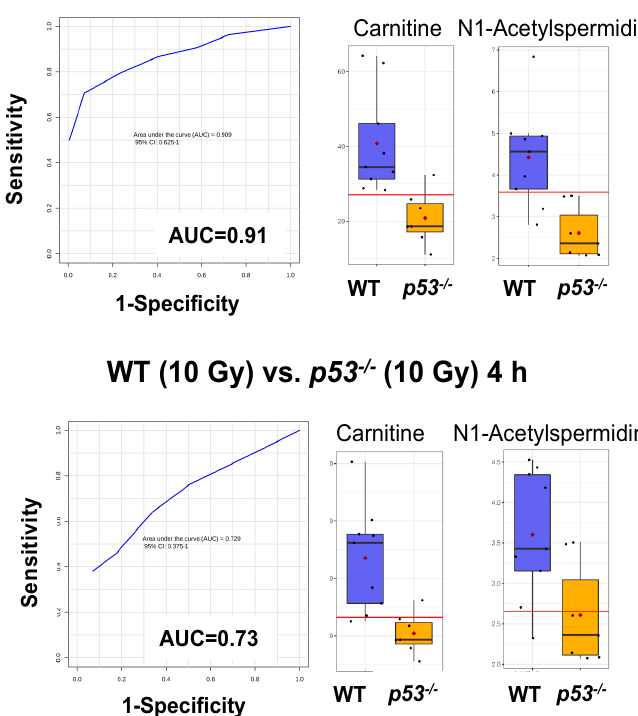
Figure 3. Hierarchical representation of impacted metabolic pathways identified in wild-type and p53 − / − mice post-irradiation. Metabolic pathways were identified in MetaboAnalyst using the Kyoto Encyclopedia of Genes and Genomes (KEGG) database, The Small Molecule Pathway Database, and Human Metabolome Database (HMDB).